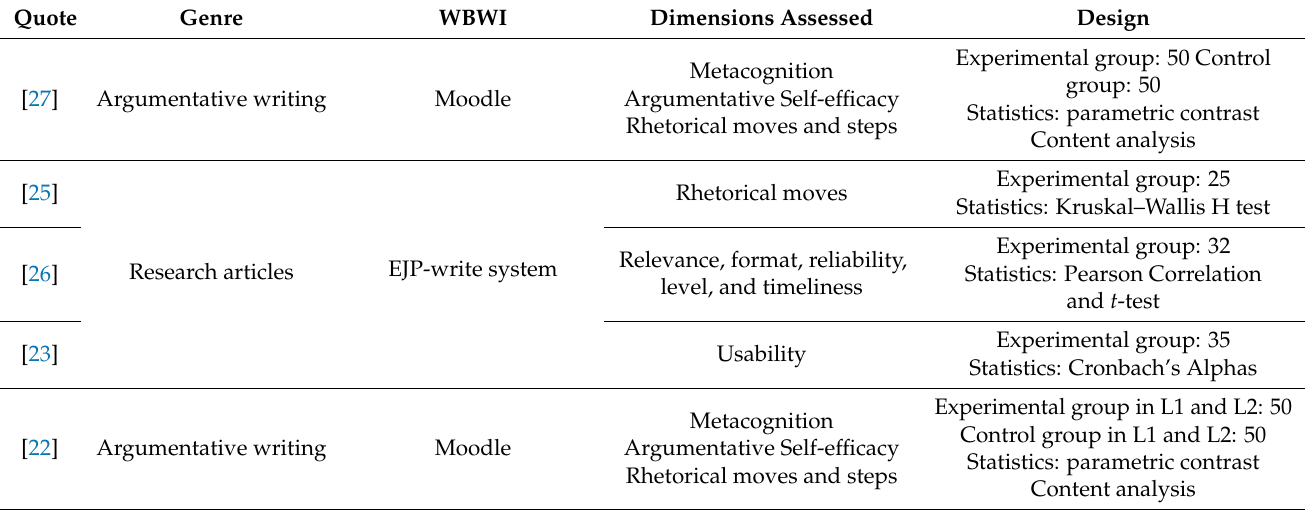
Table 2. Studies illustrating how the GBWI methodology combined with WBWI can be implemented at the university